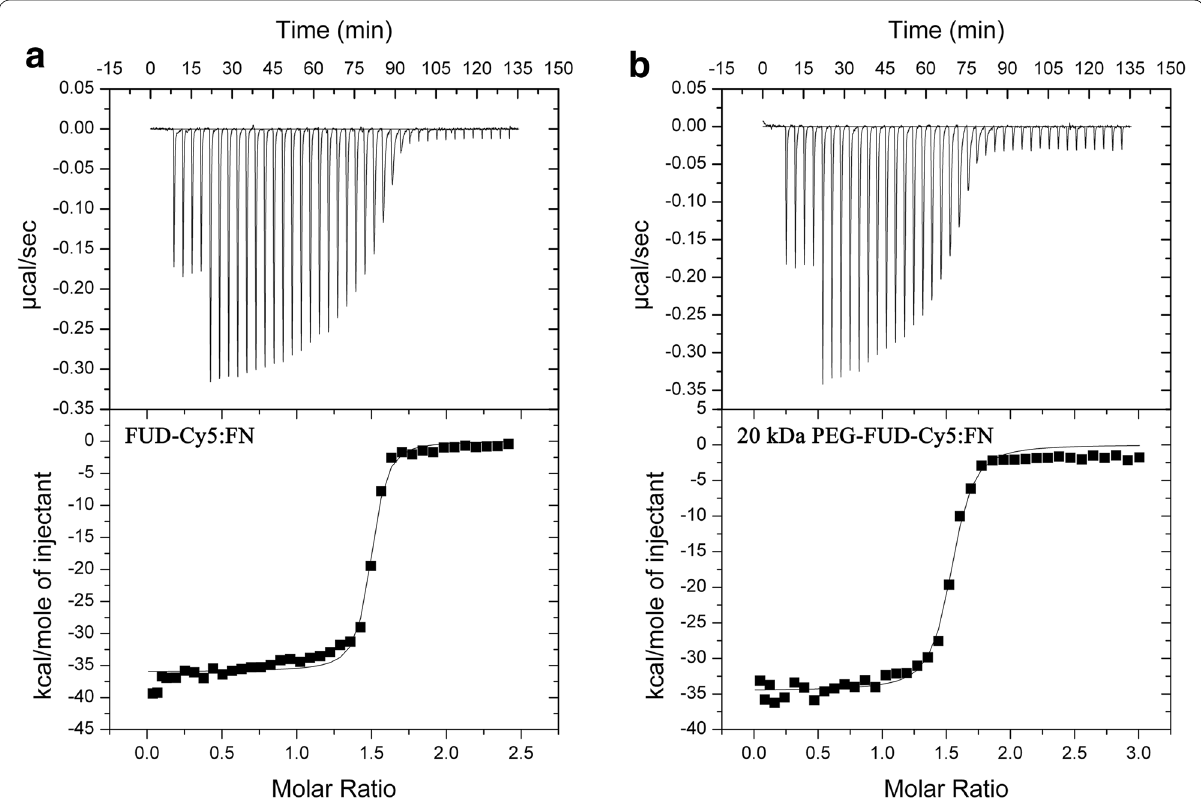
Fig. 5 Isothermal titration calorimetry (ITC) was used to determine the binding affinity (K d ) and other binding parameters of the interaction between the sulfo-Cy5 labeled peptide and human plasma fibronectin. Shown here are isotherms and thermographs of experiments involving a